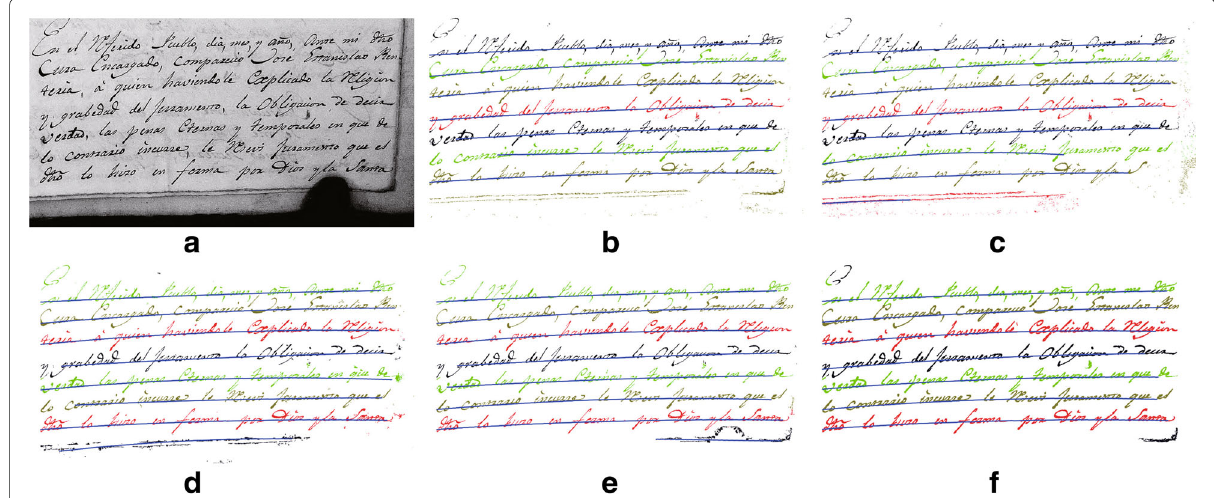
Fig. 11 a Input image. Textline detection results with several binarization methods: b Sauvola et al. [27], c Otsu [23], d Howe [7], e Ntirogiannis [21], and f our binarization